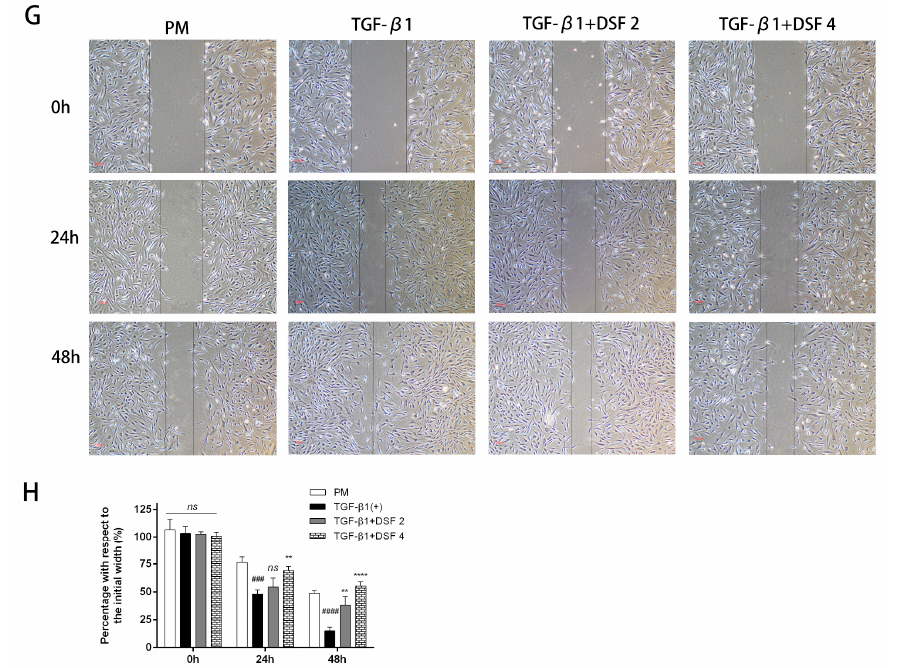
Figure 2. DSF exerts antifibrotic effects on pOFs in the GO group. ( A ) The mRNA levels of fibrotic and extracellular matrix production markers (ACTA2, FN1, CTGF, TIMP-1, COL1A1, COL1A2, COL2A1, and COL3A1) were measured, n = 5. ( B ) The protein expression levels of the indicated fibrotic markers in each group were assessed. ( C ) The protein levels were quantified, analyzed, and normalized to the level of GAPDH for each sample, n = 3. ( D ) IF staining of pOFs with FN1 (red), COL1A1 (green), and α -SMA (pink) antibodies after treatment with TGF- β 1 (10 ng/mL)/DSF (4 µ M). Cell nuclei were stained with DAPI (blue). The stained cells were examined under a fluorescence microscope (200 × ); scale bar = 50 µ m. ( E ) Photographed collagen gel contraction of pOFs after treatment with TGF- β 1 (10 ng/mL)/DSF (2 µ M, 4 µ M) for 0 h, 24 h, and 48 h. ( F ) Statistical analysis of the percentage with respect to the initial area, n = 3. ( G ) Photographed wound repairability of pOFs after treatment with TGF- β 1 (10 ng/mL)/DSF (2 µ M, 4 µ M). Scale bar = 100 µ m. ( H ) Statistical analysis of the rate of wound closure, n = 3. The data are expressed as the triplicates’ mean ± standard deviation (SD). # p < 0.05, ## p < 0.01, ### p < 0.001, and #### p < 0.0001 compared with the control; * p < 0.05, ** p < 0.01, *** p < 0.001, and **** p < 0.0001 compared with TGF- β 1 alone; ns denotes no statistical significance versus the control/TGF- β 1; assessed by one-way